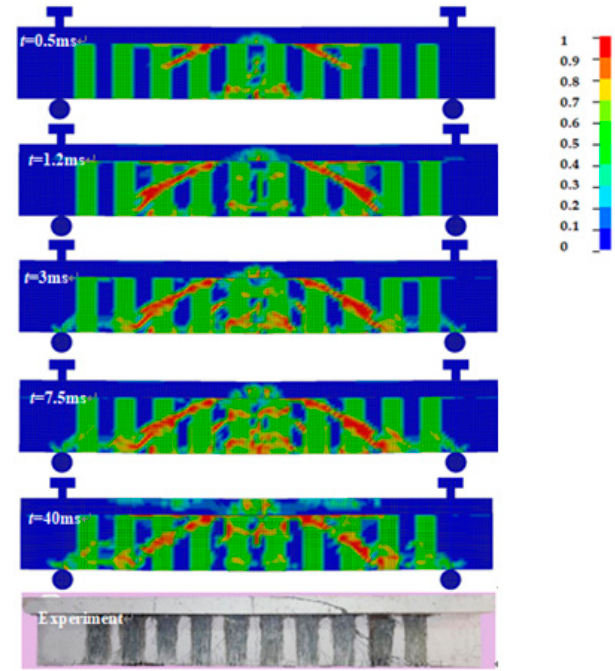
Figure 7. Failure pattern of RC T-beam with CFRP from test and simulation.